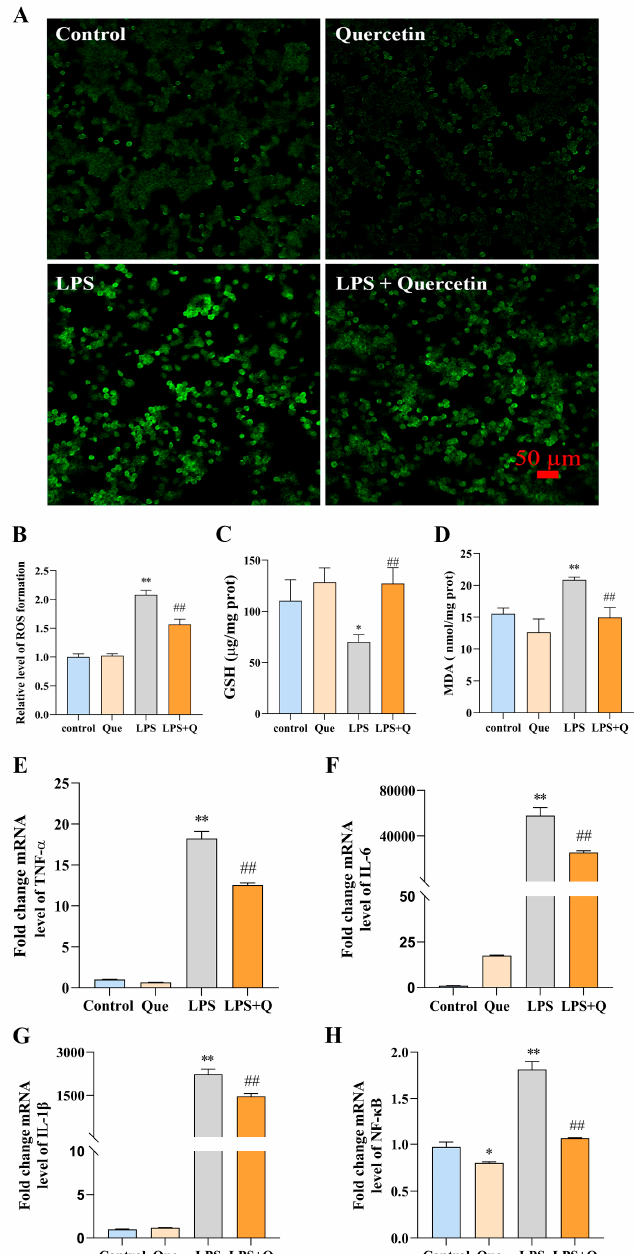
Figure 2. Effects of quercetin on antioxidant capacity and expression of inflammatory cytokines in LPS-induced RAW267.4 cells. ( A ) Images of DCF fluorescence intensity. ( B ) The relative levels of ROS generation. ( C , D ) The effect of quercetin on the intracellular levels of GSH and MDA. The expression of ( E ) TNF- α , ( F ) IL-6, ( G ) IL-1 β and ( H ) NF- κ B mRNA levels were determined by qRT-PCR. * p < 0.05 and ** p < 0.01 compared to the blank control group, and ## p < 0.01 compared to the LPS group were considered statistically significant